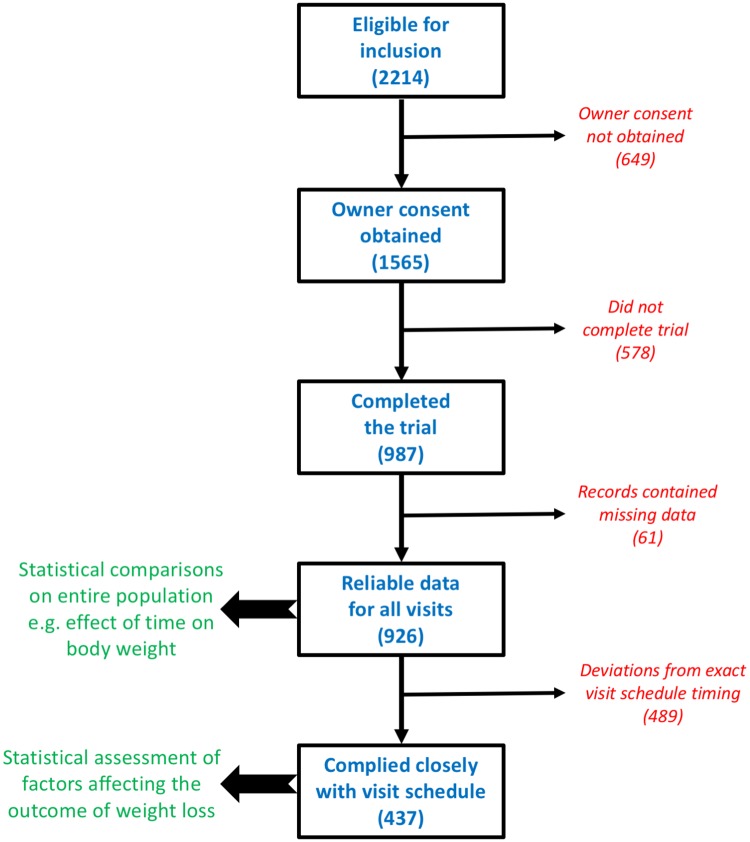
Flow diagram illustrating the number of dogs eligible and participating in the study.